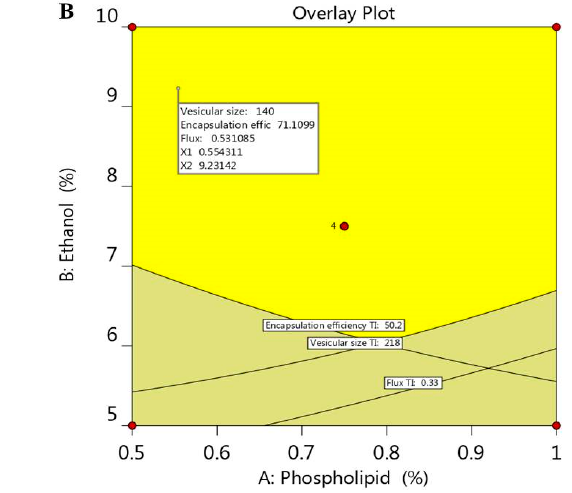
Figure 4. ( A ) Optimization plot screening the effect of different variables X 1 and X 2 on overall desirability and ( B ) overlay plot of the desired responses for the optimal region of ethosome formulation.